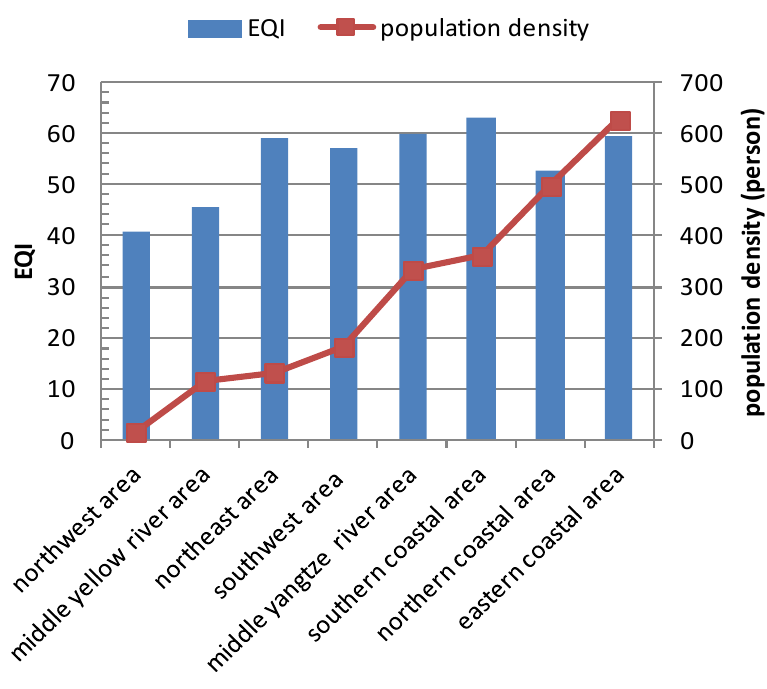
Figure 12. Relationship between EQI and population density in eight economic regions in 2005.